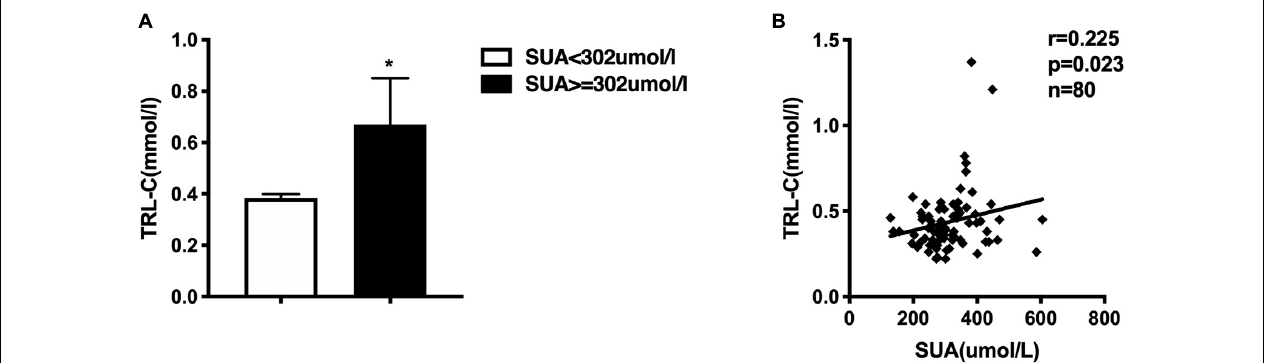
FIGURE 1 | (A) Comparison of serum triglycerides-rich lipoprotein cholesterol (TRL-C) between high SUA group and low SUA group, the Mann-Whitney U -test showed that TRL-C levels were significantly greater in the high SUA group than in the low SUA group, * p < 0.05. (B) Serum uric acid is positively correlated to TRL-C concentration in all subjects.